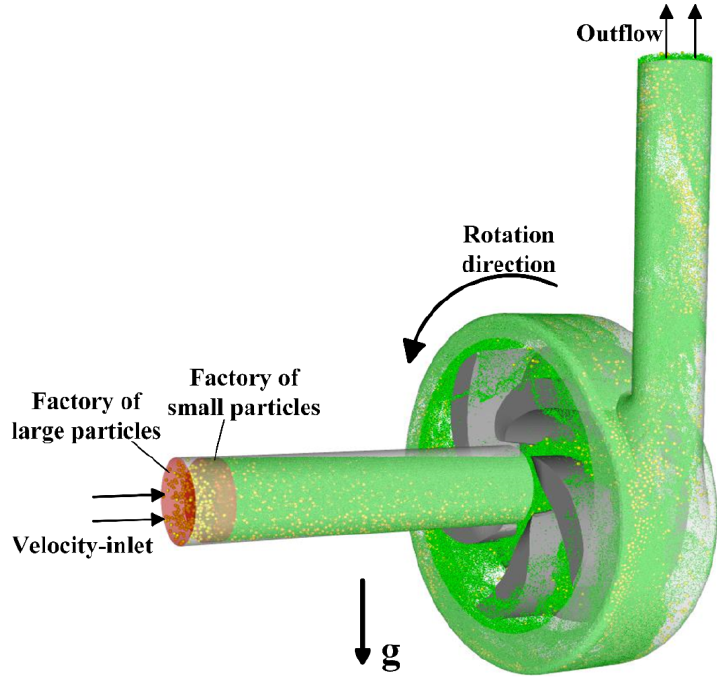
Figure 4. Fluid region of centrifugal pump. Table 2. Material parameters.